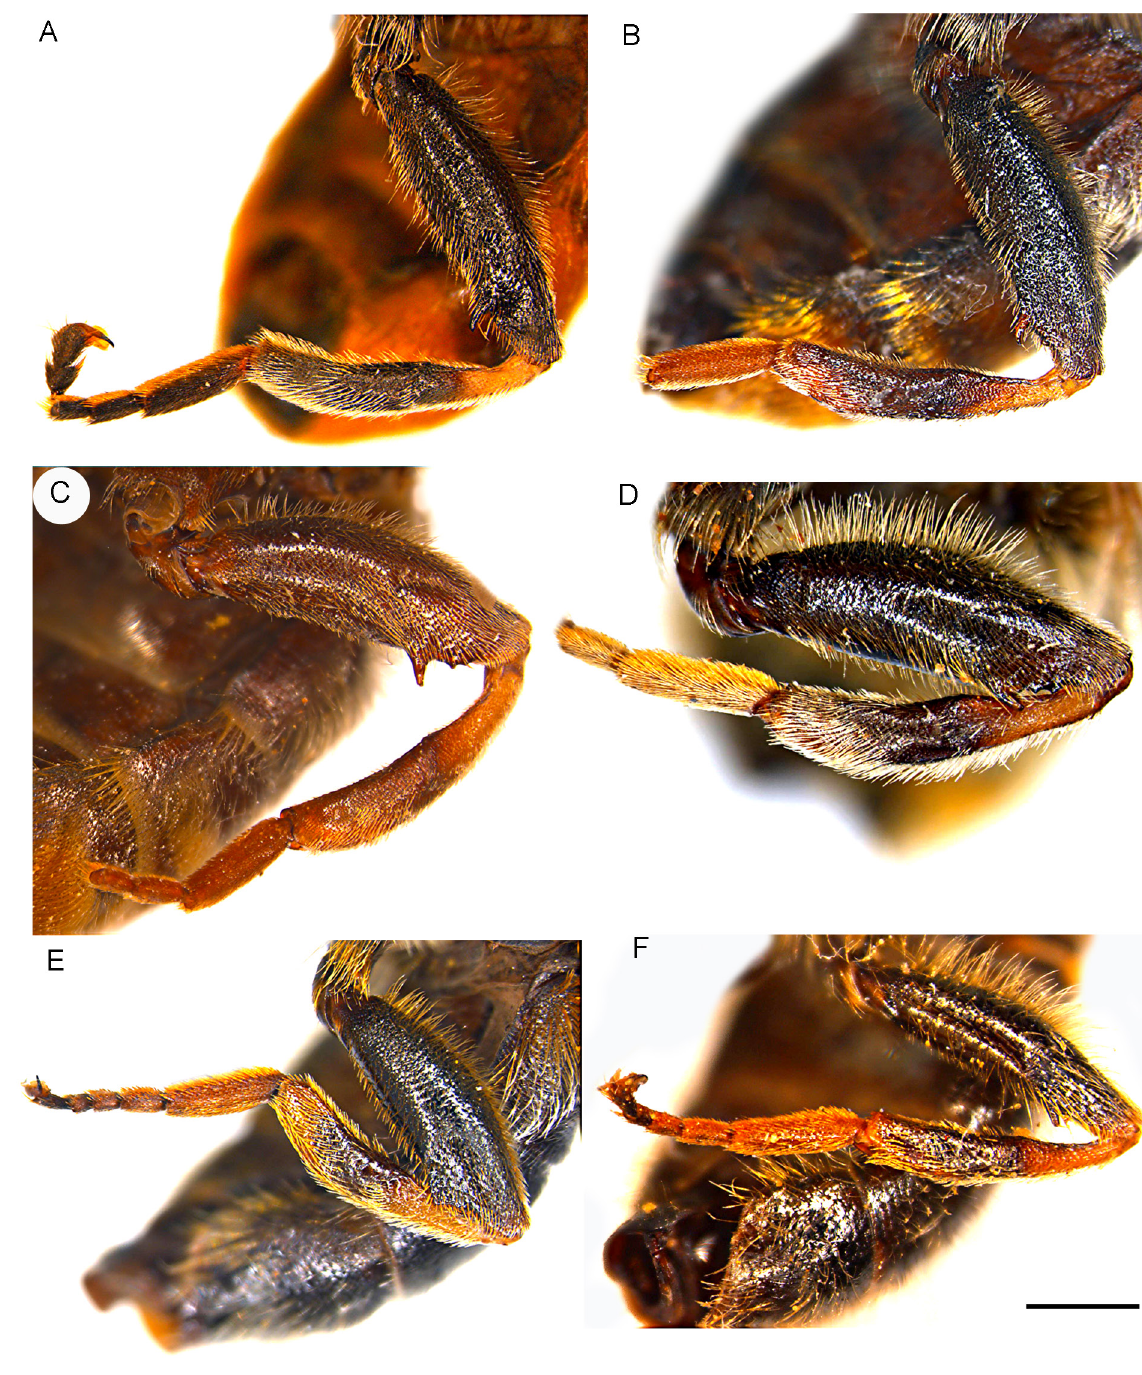
Fig. 6. Male metaleg, lateral view. A . Merodon bombiformis Hull, 1944 (FSUNS; FSUNS ZA2_079). B . M. multifasciatus Curran, 1939 (USNM 2052372; FSUNS ID 04512). C . M. vittatus Vujić & Likov sp. nov., holotype (NBCN; FSUNS ID 04085). D . M. zebra Vujić & Radenković sp. nov., paratype (NBCN; FSUNS ID 05174). E . M. lotus Vujić & Radenković sp. nov., paratype (FSUNS; FSUNS ID ZA6_066). F . M. nasicus Bezzi, 1915 (TAUI; FSUNS ID 04972). Scale bar = 2